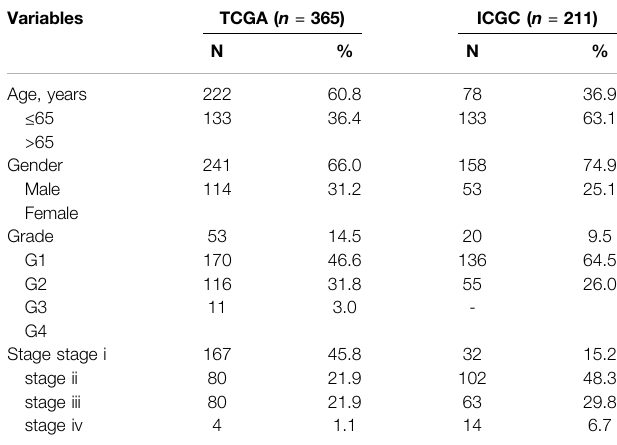
TABLE 1 | Clinical features of HCC patients from TCGA database and ICGC database.